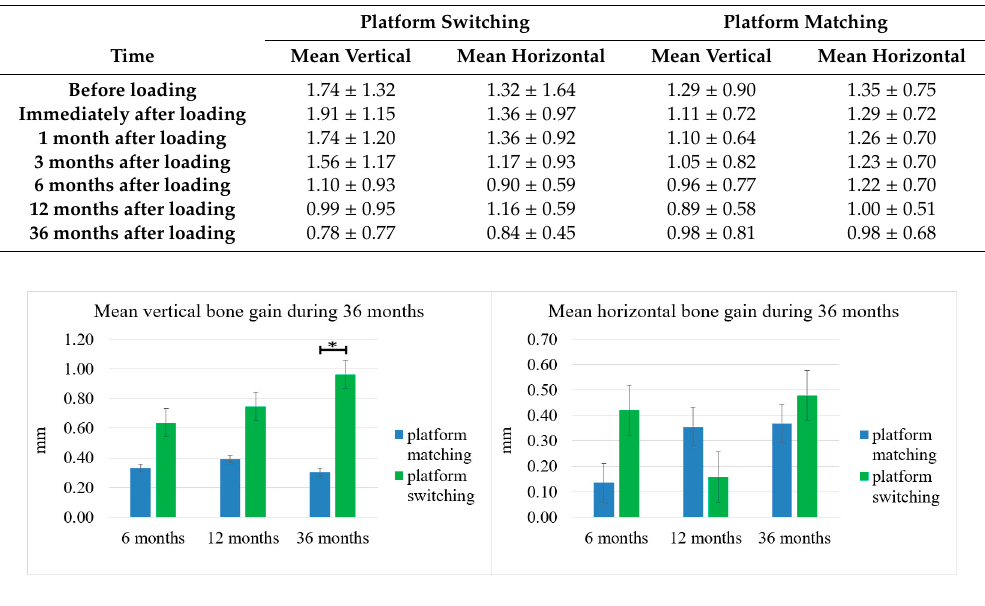
Figure 6. Ratio of the bone supported surface along the implant fixture over the 36-month period. Percentage of bone contact along the implant for 36 months of follow-up in the PM and PS implants. Asterisks (*) indicate a statistically significant difference ( p < 0.05).